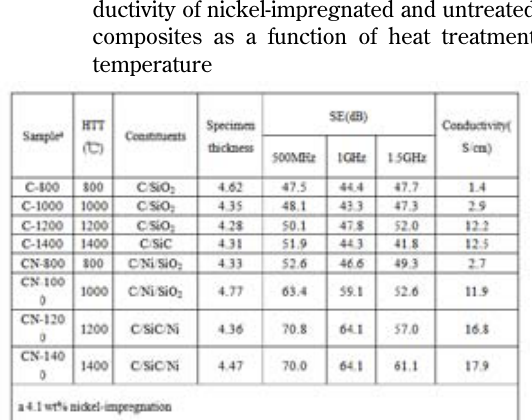
Fig. 5 Procedure of nickel-loaded composites preparation.